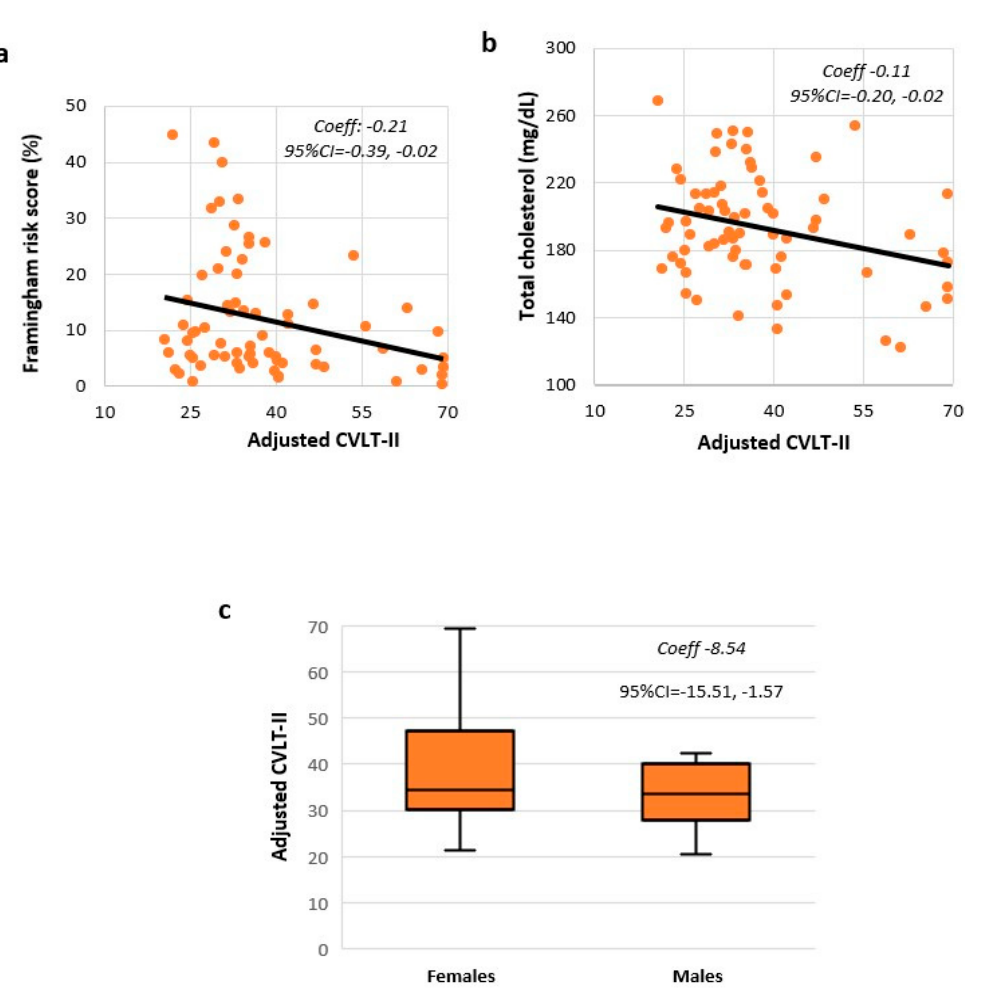
Figure 1. Cardiovascular risk and CVLT-II. Scatter plots show the association between the California Verbal Learning Test (CVLT-II) and the Framingham risk score ( a ), and total cholesterol levels ( b ); Box-and-whisker plot shows the association between CVLT-II and sex ( c ). Results are reported from a linear regression model ( a ) and a stepwise linear regression model ( b , c ).